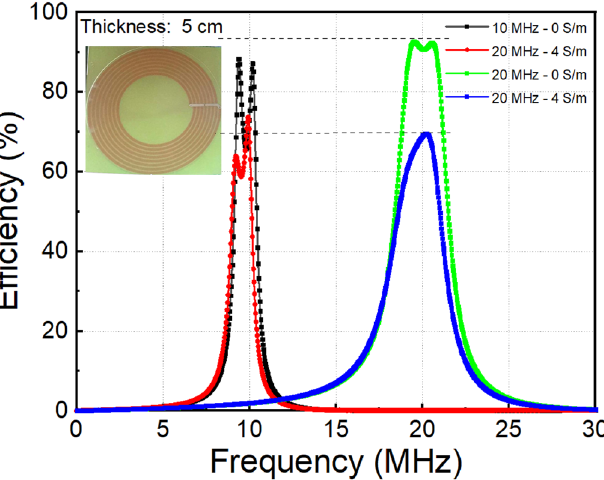
Figure 10. Measured transfer efficiency of two MR-WPT systems with resonator diameter of 10.0 cm.